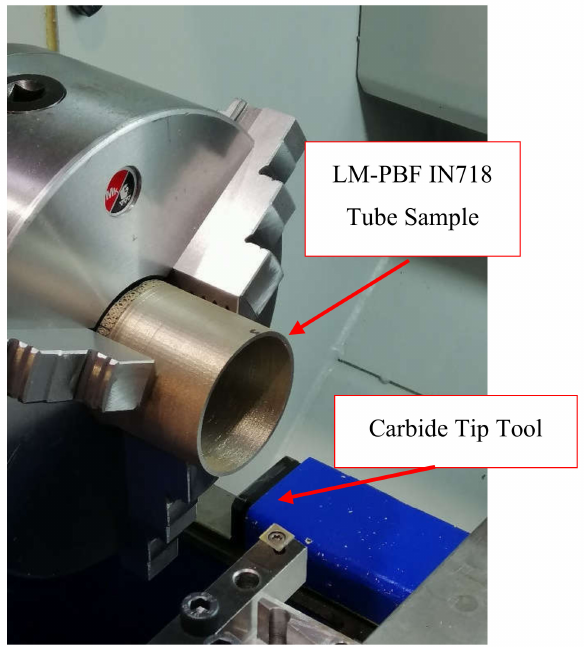
Figure 3. Experimental setup for